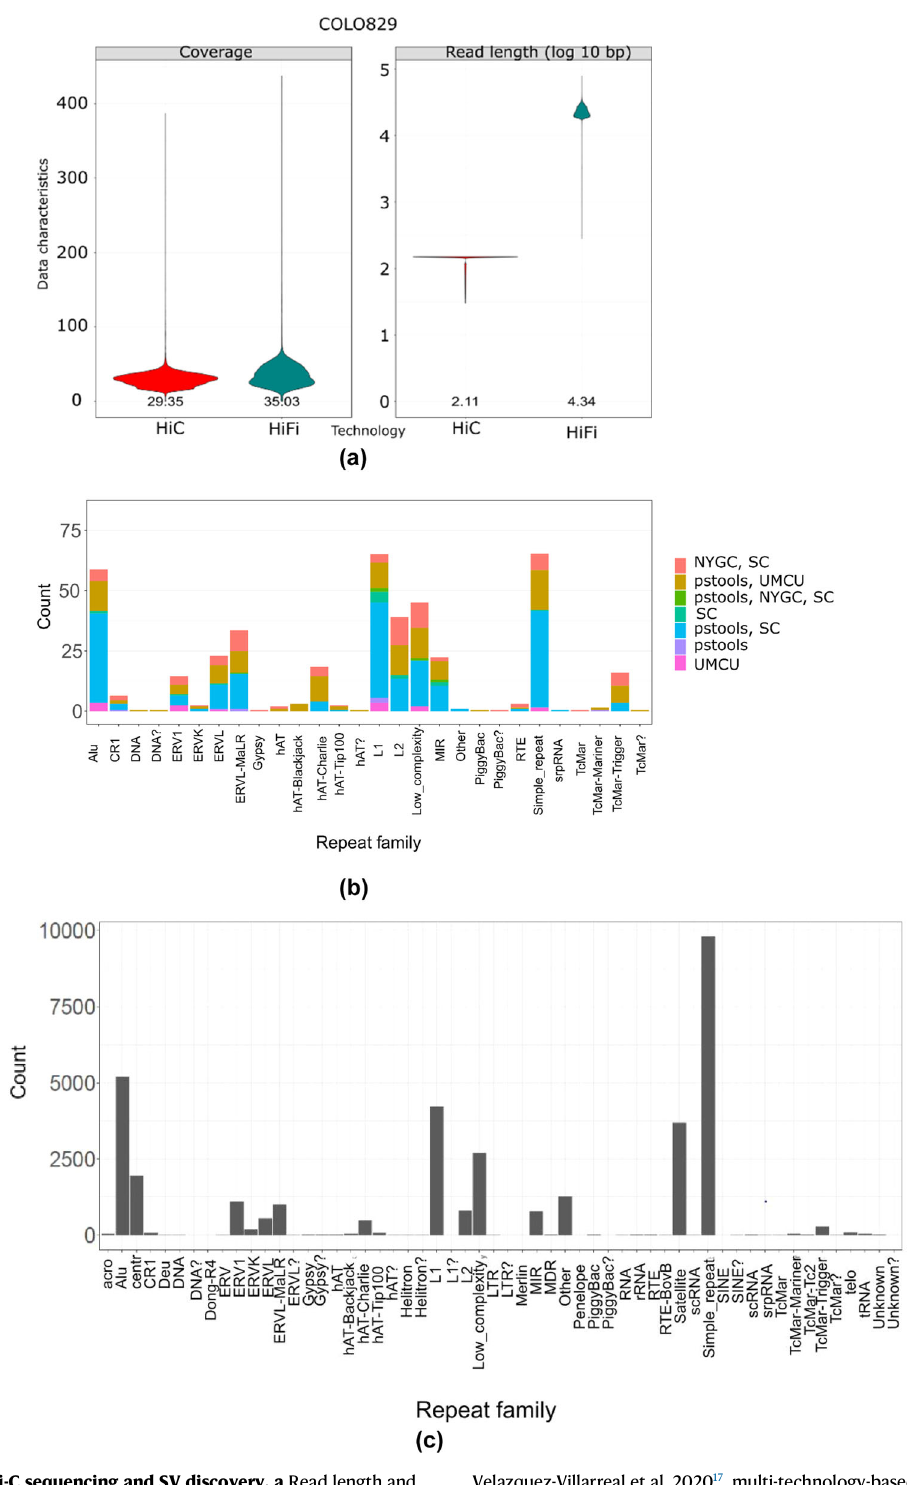
Velazquez-Villarreal et al. 2020 17 , multi-technology-based UMCU call set (https:// github.com/UMCUGenetics/COLO829_somaticSV)andpstools.Eachbarshowsthe number of variants agreed between call sets for speci fi c repeat elements. c Germline SV calls in repeat elements. X -axis: repeat elements, Y -axis: number of variants (Bottom). Source data are provided as a Source Data fi